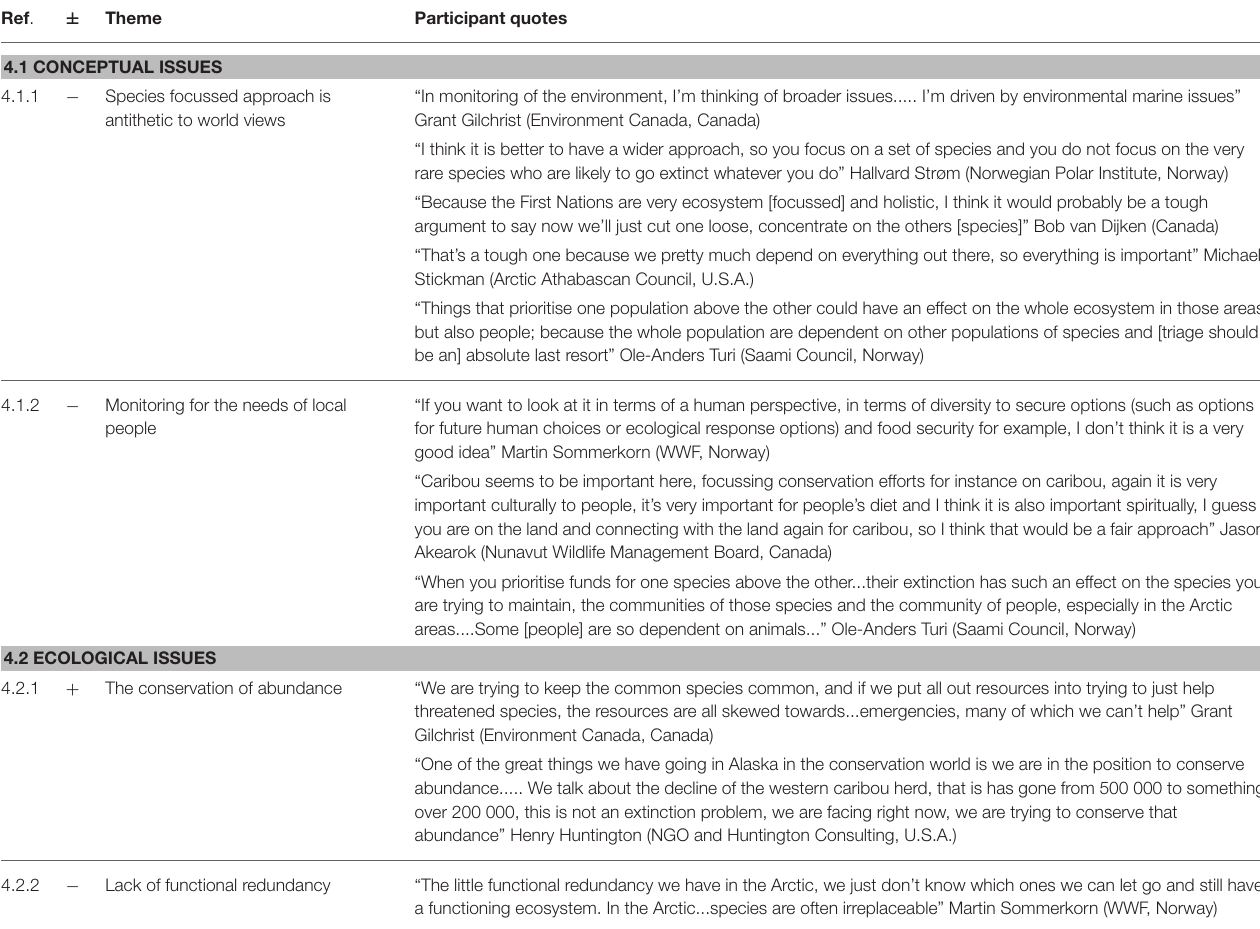
TABLE 2 | Summary of stakeholder conceptual and ecological issues in monitoring triage for arctic wildlife. Ref